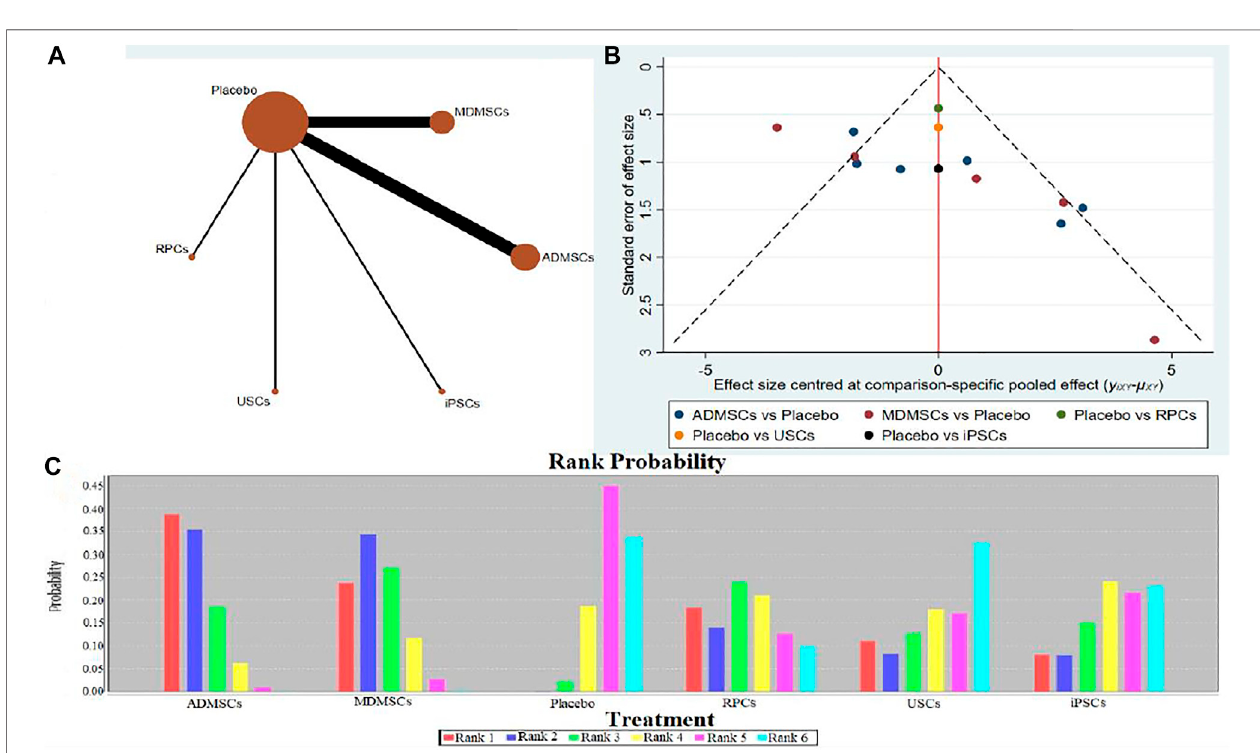
FIGURE 10 | Network Meta-analysis of proliferation of resident cells in stem cell group and negative control group in early stage after administration (A) Evidence network diagram; ( B) The comparison-correction funnel plot; (C) The ranking results).